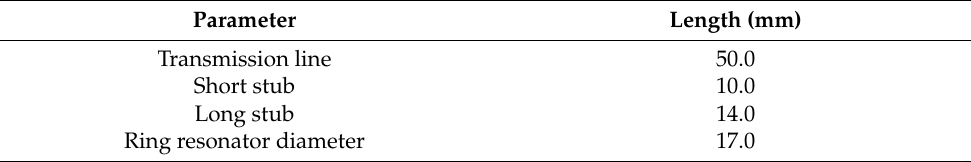
Figure 5. Photograph (50 × 80 mm 2 ) of the calibrating elements employed to measure and extract the electrical parameters of the resin substrate material and the fabrication process. Transmission lines are 850 µ m wide and 50 mm long, and gaps in the ring resonator network are 360 µ m. Table 2. Calibrating network physical dimensions for both substrates of different